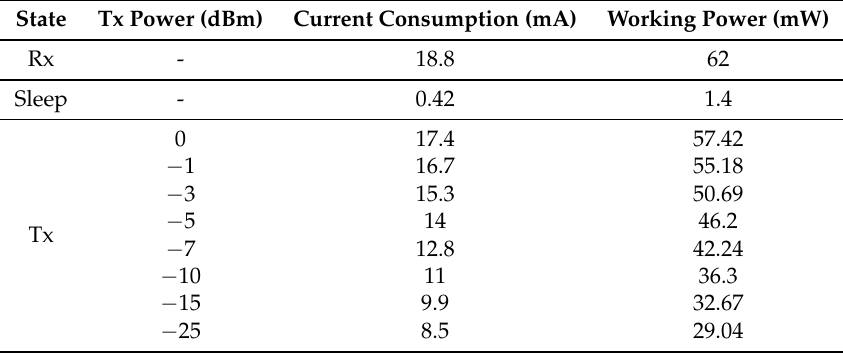
Table 1. The power consumptions in different states for CC2420.